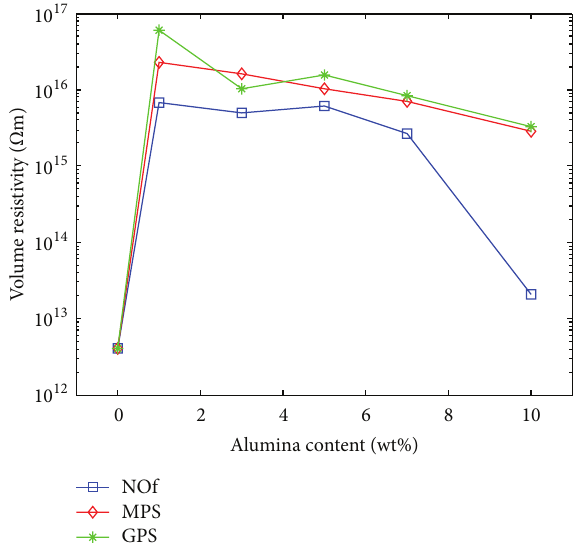
Figure 5: Volume resistivity versus alumina content: comparison among nonfunctionalized and functionalized